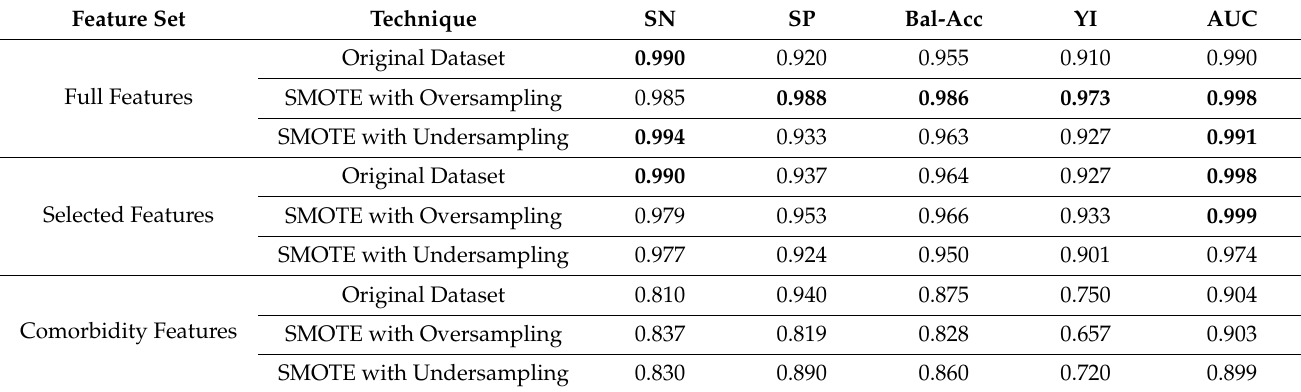
Table 2. Result of the proposed model for mortality prediction (Case 1).